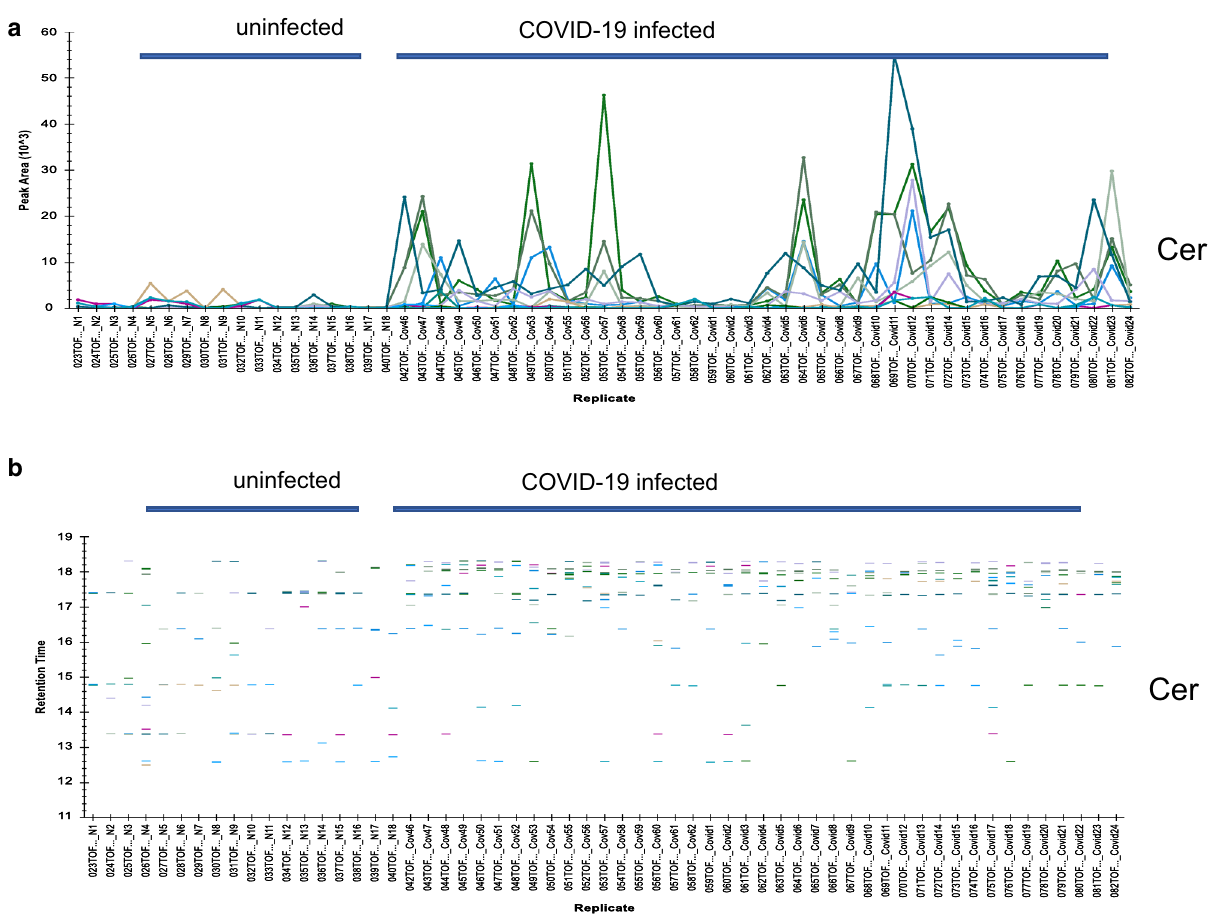
Figure 3. Grouping of identified COVID-19 infection-dependent metabolites into lipid classes. Comparative abundance profile of the identified subclasses of lipids per class in the plasma of uninfected and COVID-19- infected individuals. An over view of levels, as measured by peak area (Y- axis), of metabolites in COVID-19- infected and control samples as measured by LC–MS/MS IDA analysis. Each color line represents a metabolite as defined in the inclusion list, grouped into lipid subclass, and lipid class. ( a ) Analysis of observed changes in peak area of subclasses of the Cer (Y-axis) in uninfected (samples N1–N18) and COVID-19-infected plasma samples (X-axis, Samples Covid1–24, Covid 46–62). ( b ) Changes in the observed retention time of the subclasses of Cer across all samples. ( c ) Analysis of observed changes in peak area of subclasses of the PE, PG, PI, and PS class (Y-axis) in uninfected and COVID-19-infected plasma samples (X-axis). Each metabolite defined in the inclusion list is represented in a different